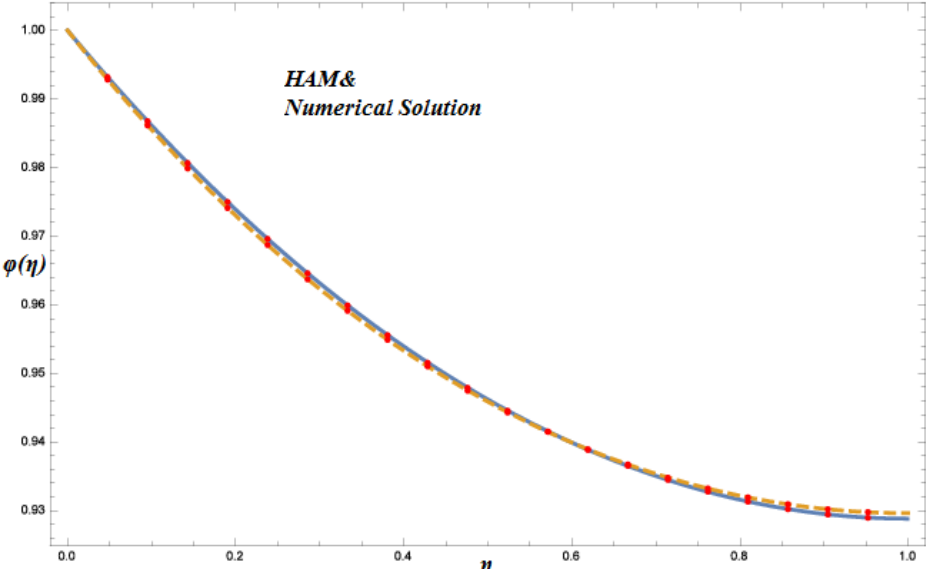
Λ = 0.1, β = 1, S = 0.2. Appl. Sci. 2016 , 6 , 334